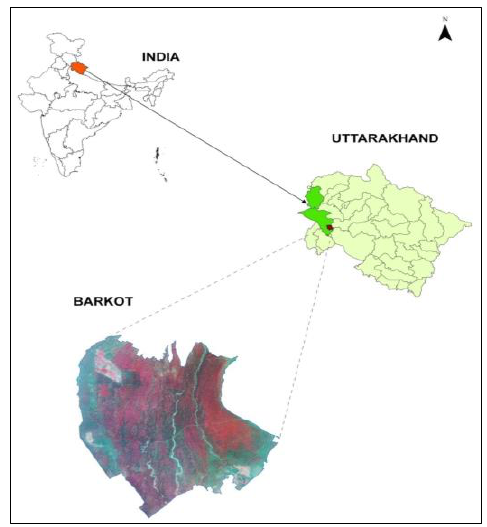
Fig. 1 Location of Barkot Forest Range in